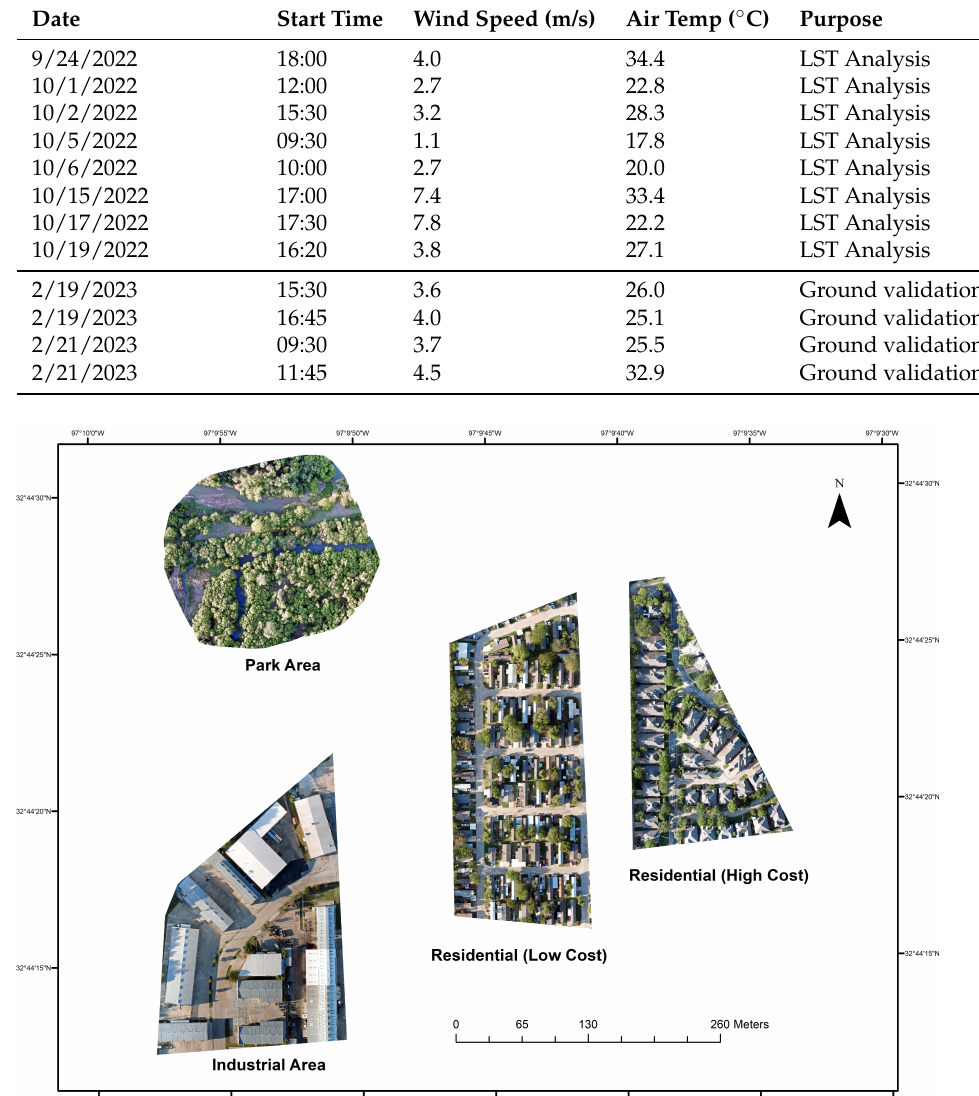
Figure 2. Orthomosaiced image of PA, IA, RLC, and RHC captured using Zenmuse H20T wide-angle camera (24 September